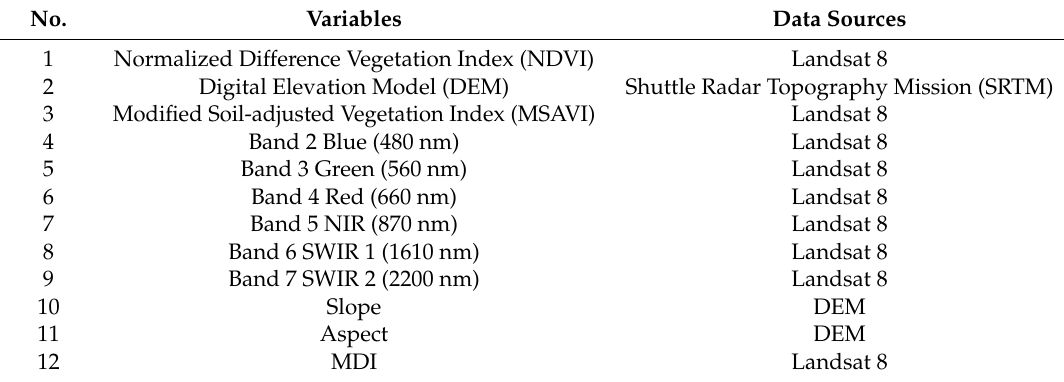
Table 1. Input variables considered in the derivation of the object